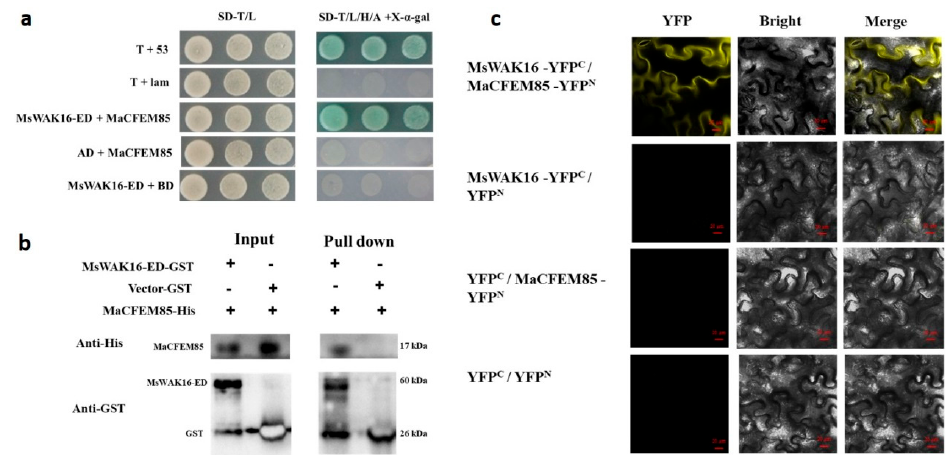
Figure 2. Validation of the interaction between MaCFEM85 and MsWAK16. ( a ) Verification of the interaction between AD-MsWAK16-ED and BD-MaCFEM85 in Y2H Gold yeast. pGBKT7-53 and pGADT7-RecT (T+53) and pGBKT7-lam and pGADT7-RecT (T+Lam) were used as the positive and negative controls, respectively. ( b ) In vitro GST pull-down assays showing the interaction between MaCFEM85 and MsWAK16-ED. ( c ) BiFC assays showed that MaCFEM85 and MsWAK16 interacted when co-expressed in N. benthamiana leaf cells. Photos were taken at 30 h after infiltration with laser scanning confocal microscopy of yellow fluorescent protein (YFP) (514 nm excitation and 527 nm emission), bright field microscopy, and merged confocal and bright field. Scale bar = 20 µm. YFP N and YFP C represent pUC-SPYNE and pUC-SPYCE vectors, respectively.